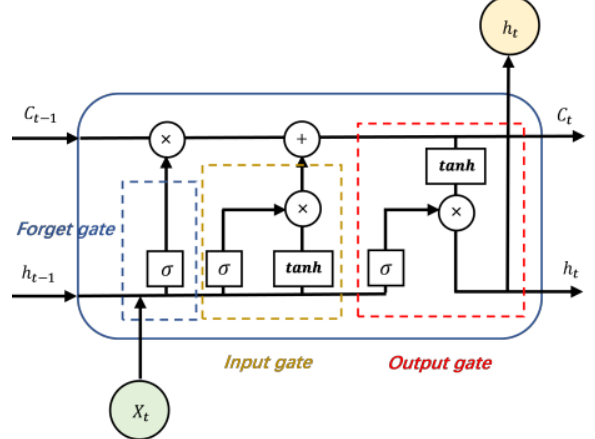
Figure 3. The general structure of the LSTM memory